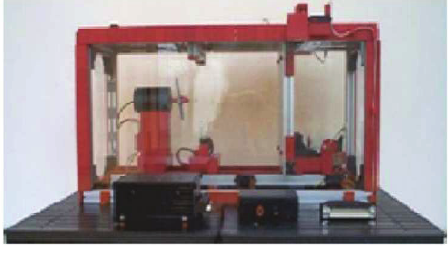
Fig.1. Scale model of a